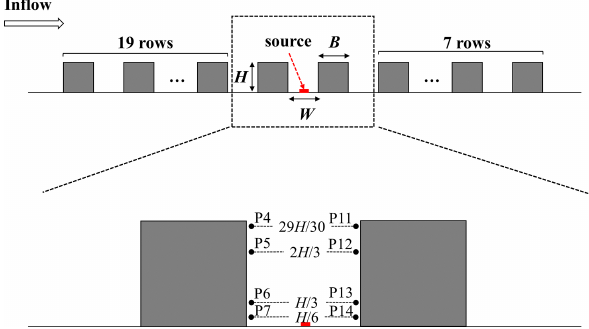
Figure 7. The schematic diagram of the 2D pollutant dispersion simulation setting.